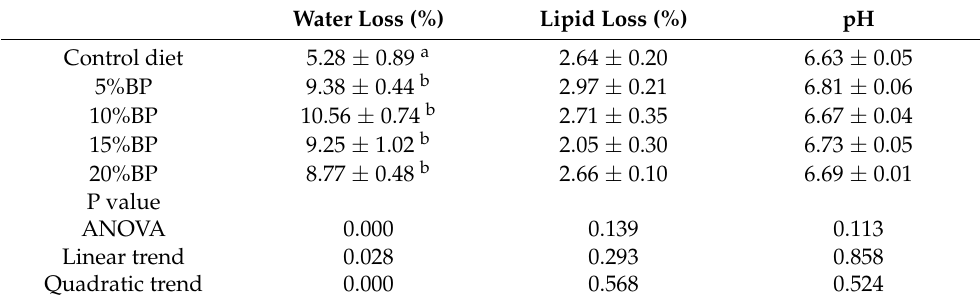
Table 5. Water-holding capacity and pH of muscle in grass carp fed a diet with paper mulberry (BP) for 8 weeks.